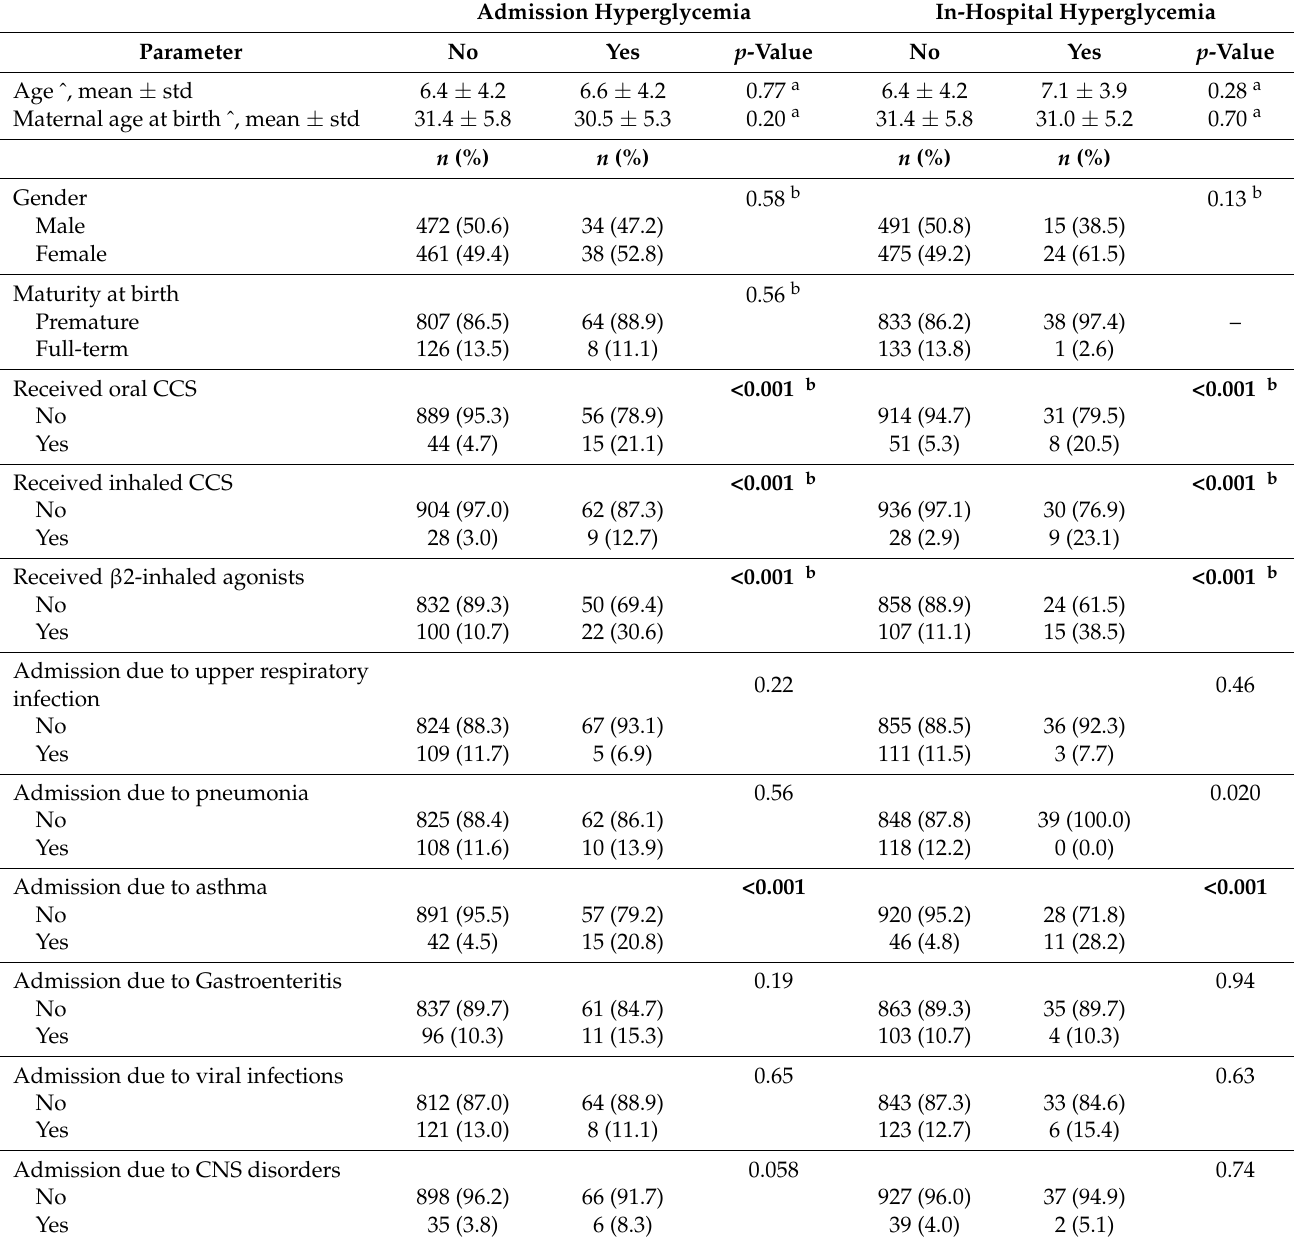
Table 3. Association of admission and in-hospital hyperglycemia with selected parameters of inter- est. std: standard deviation; CCS: Corticosteroids; a : t -test; and b : chi-square/Fisher’s exact test. Significant p -values are shown in bold. ˆ continuous